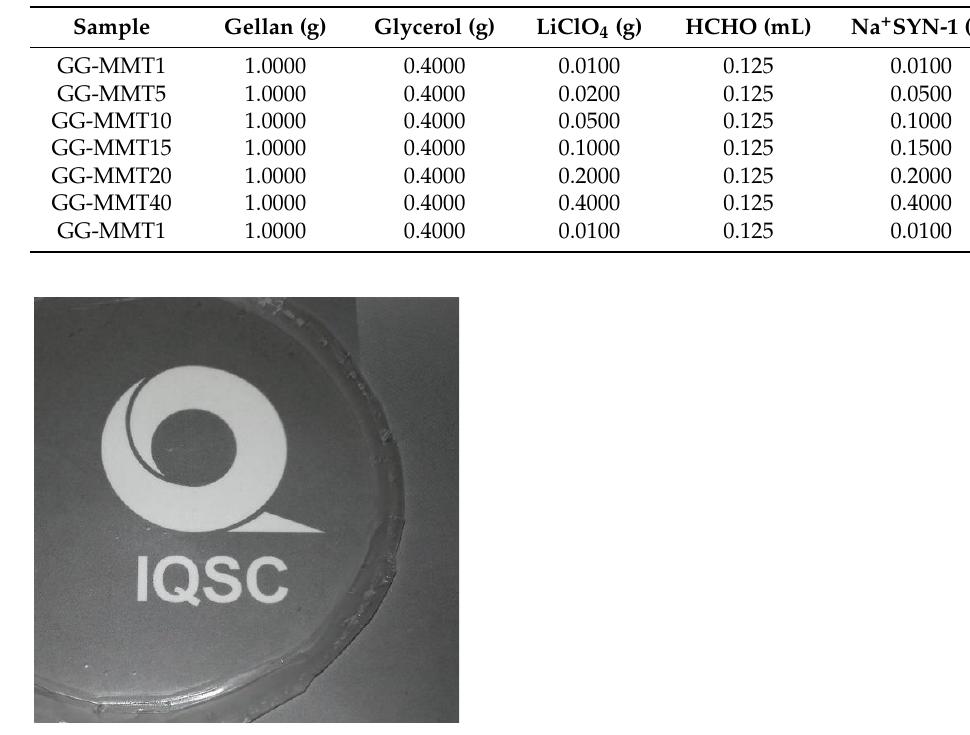
Figure 9. Picture of GG-MMT10 NPE membrane.